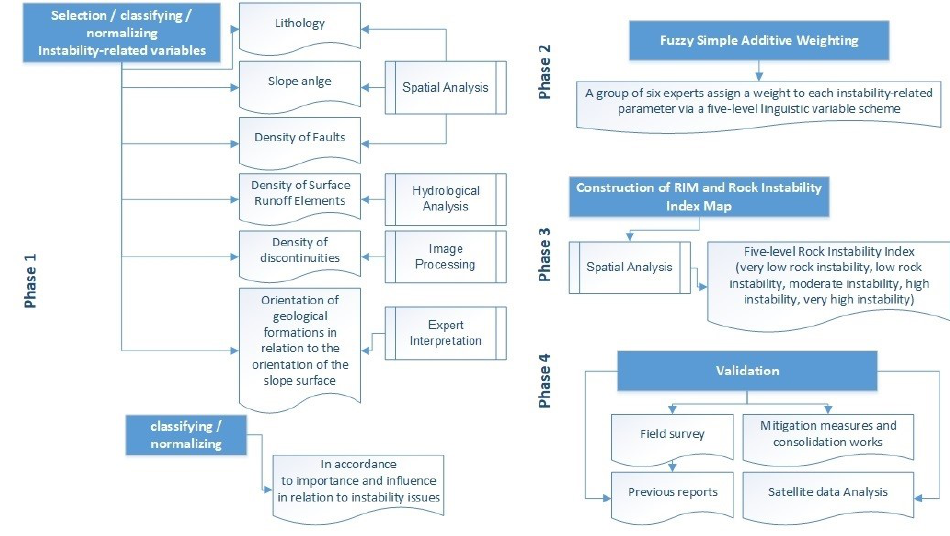
Figure 3. The flowchart of the developed methodological